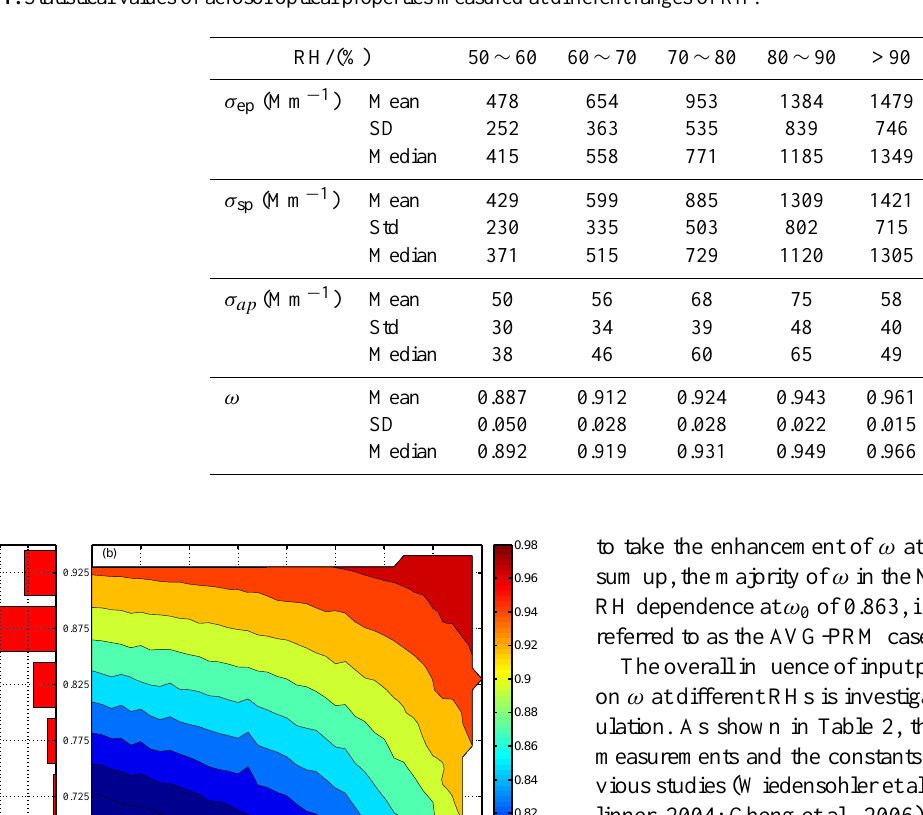
Table 1. Statistical values of aerosol optical properties measured at different ranges of RH.